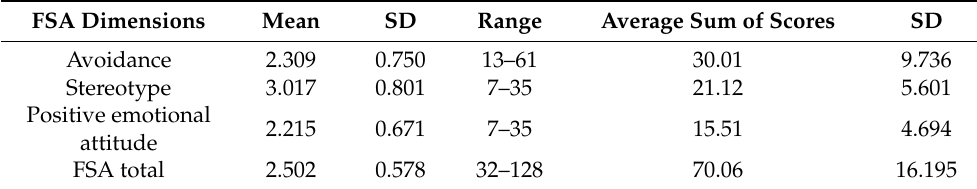
Table 4. Fraboni Scale of Ageism (FSA) means (n =